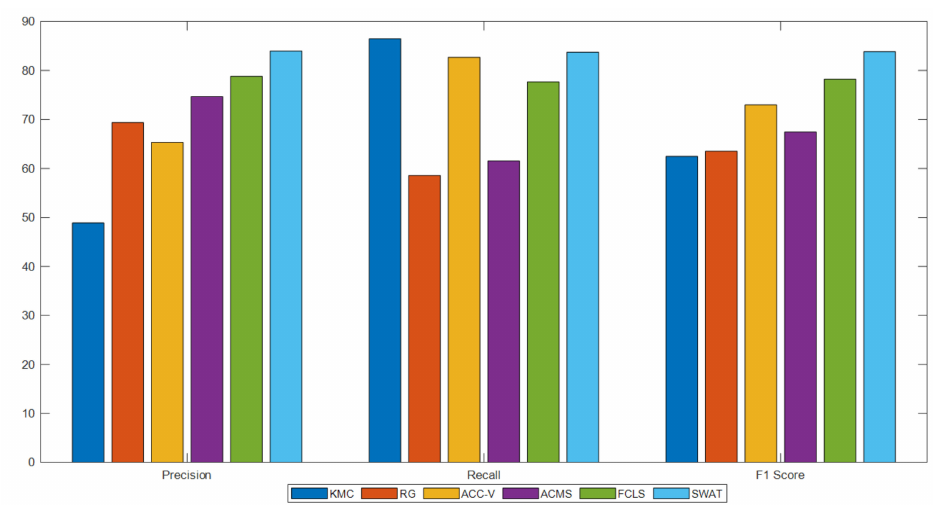
Figure 9. Statistical comparison of segmentation methods (DIARETDB1 dataset).